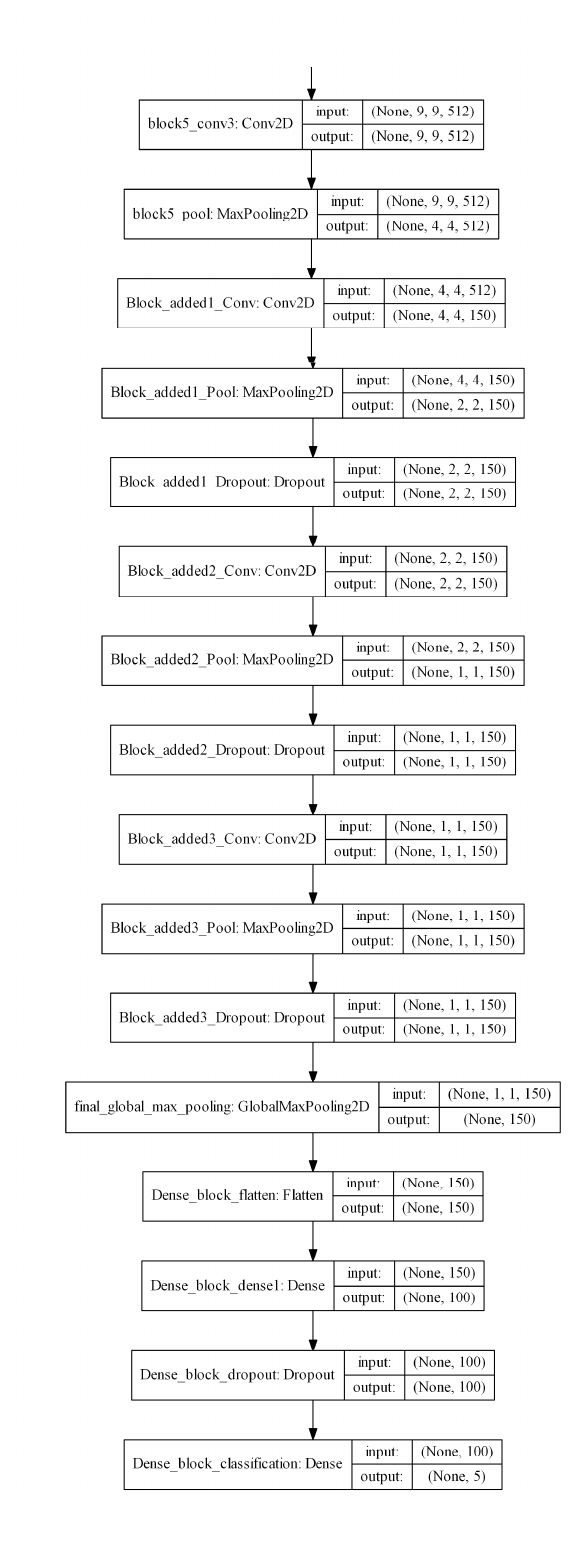
Figure A1. Architecture of the Convolutional Neural Networks algorithm with Transfer Learning.